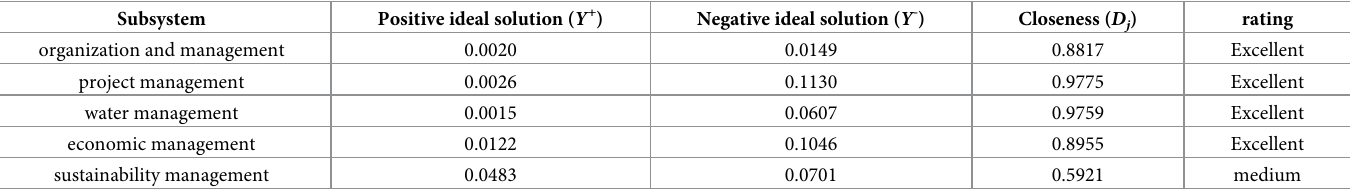
Table 7. Euclidean spatial distances between subsystems and ideal solutions in the water-user association model.